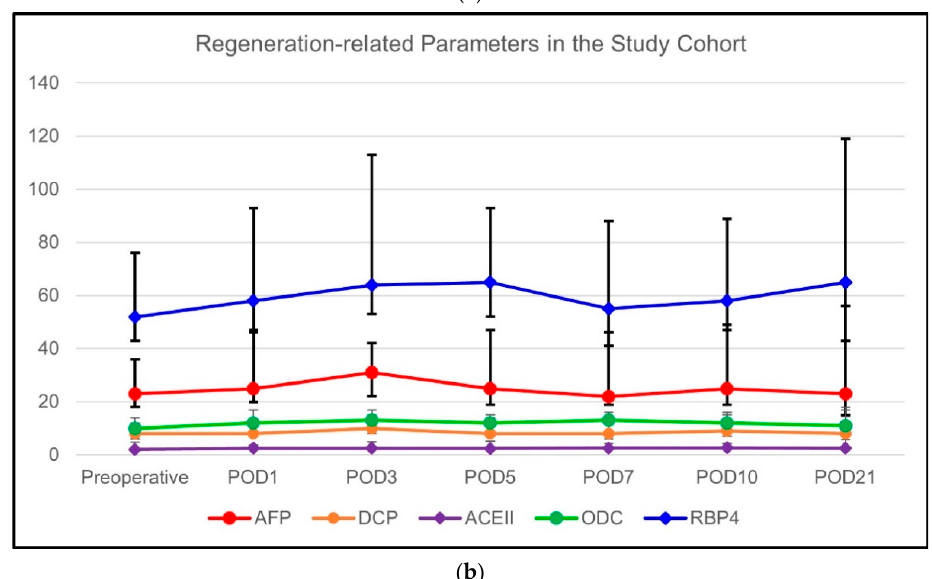
Figure 1. (a) The course of routine biochemical blood parameters of the LLDs in the study group; and (b) the course of regeneration-related biochemical parameters of the LLDs in the study group.